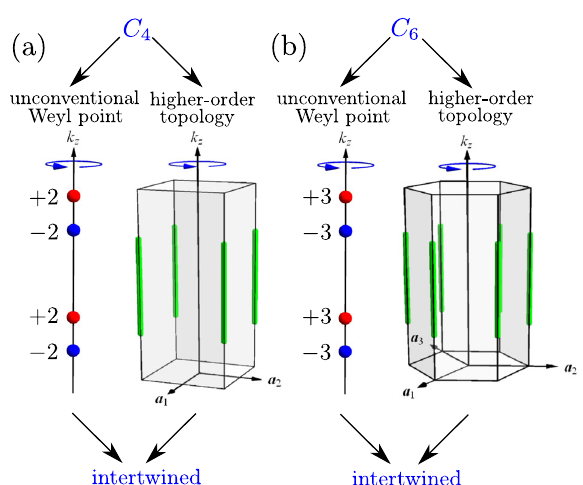
Fig. 1 Intertwining topological phases by crystalline symmetry. Red and blue dots represent Weyl points, and green sold lines denote hinge states from higher-order topology. a The fourfold rotation symmetry ( C 4 ) stabilizes double-Weyl points and higher- order topology at the same time. The interplay between the two phases results in an intertwined double-Weyl phase. b The sixfold rotation symmetry ( C 6 ) stabilizes triple-Weyl points and higher-order topology at the same time, resulting in an intertwined triple- Weyl